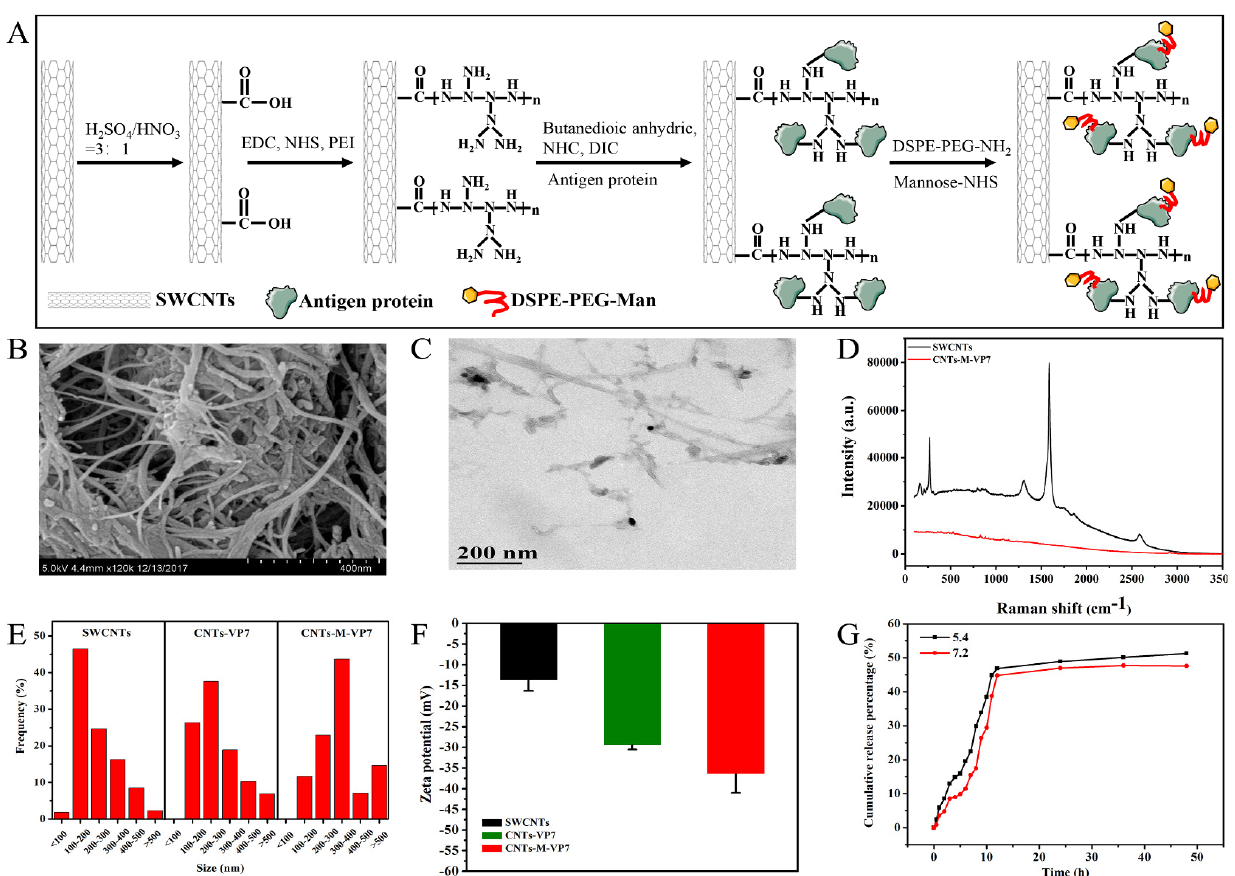
Figure 1. Characterization of nanovaccine. ( A ) Schematic illustration to show the step-by-step preparation of CNTs-M-VP7 nanovaccine. ( B ) Representative scanning electron microscopy image, and ( C ) transmission electron microscopy image of the SWCNTs-MG nanovaccine. ( D ) Raman analysis. ( E ) Dynamic light scattering analysis. ( F ) Zeta potential analysis. ( G ) Antigen release at 28 ◦ C under two di ff erent pH conditions (pH 5.4 and 7.2) in